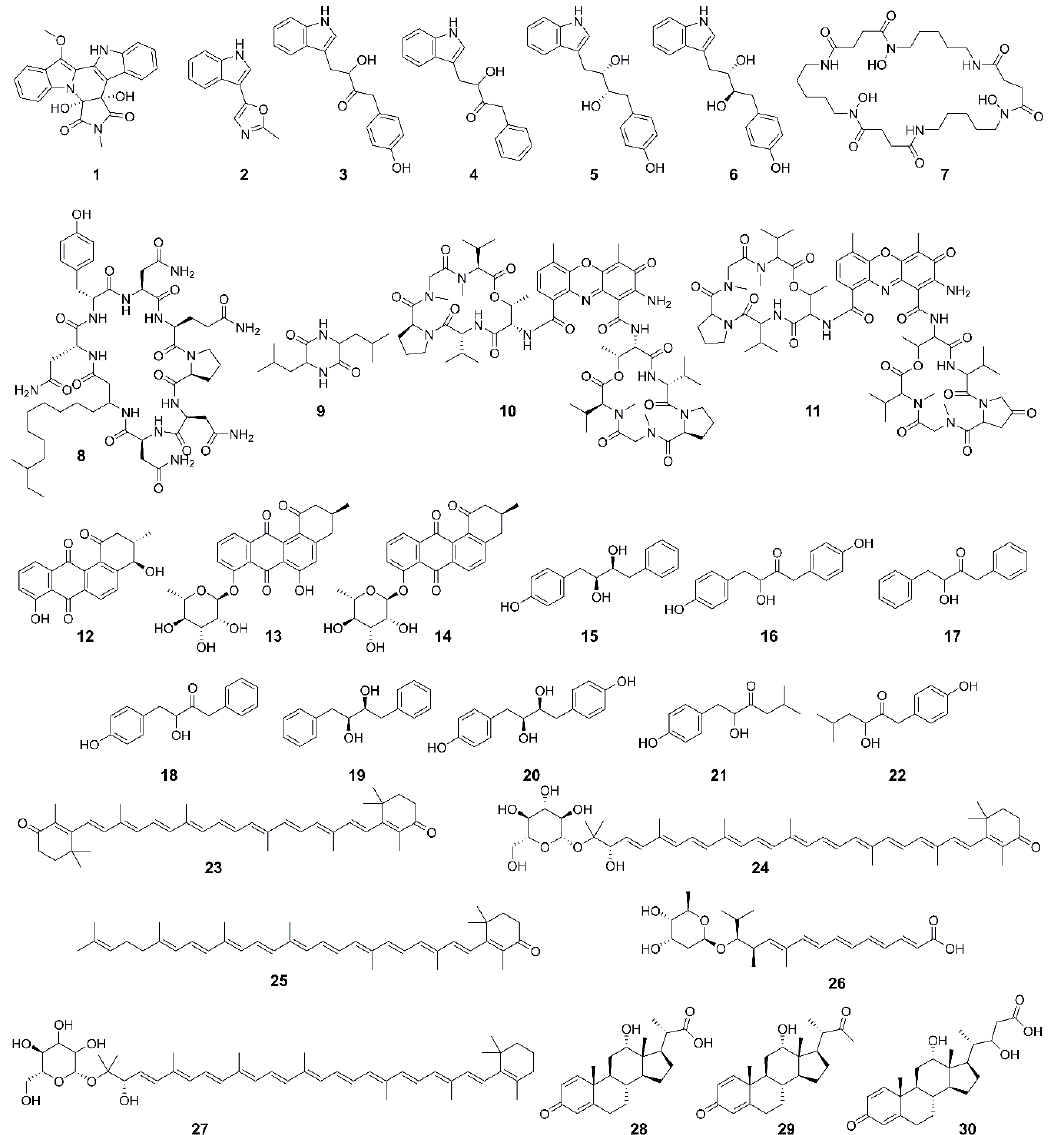
Figure 2. Chemical structures of Gordonia -derived compounds. The names, classification according to building blocks, and SMILES are listed in Table S4.